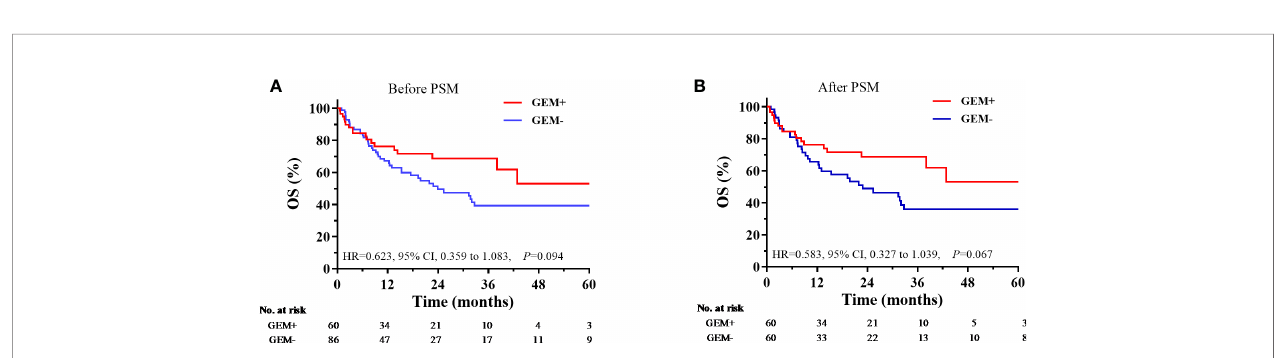
FIGURE 3 | Comparison of overall survival according to the use of asparaginase-containing chemotherapy with and without gemcitabine. (A) Before PSM, (B) After PSM. CI, con fi dence interval; GEM+, with gemcitabine; GEM-, without gemcitabine; HR, hazard ratio; OS, overall survival; PSM, propensity score